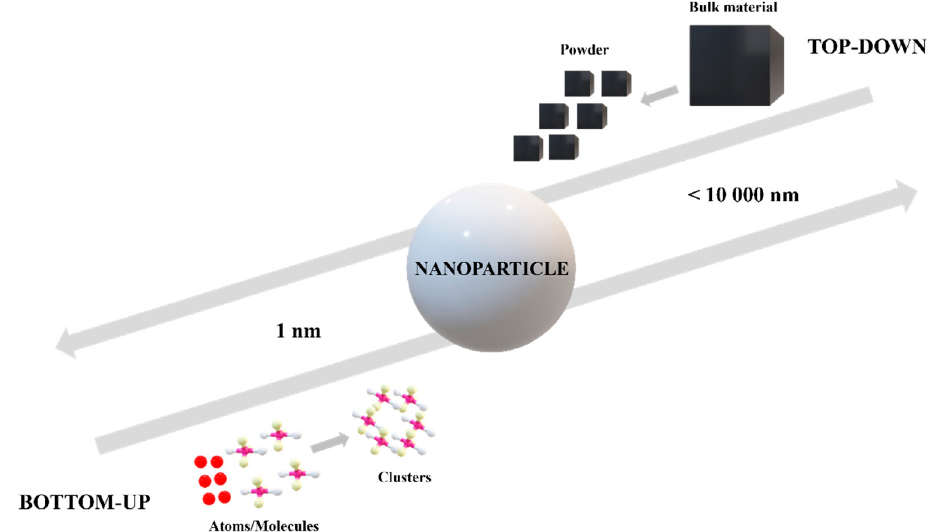
Figure 2. Top-down methods versus bottom-up methods from a nanoparticles